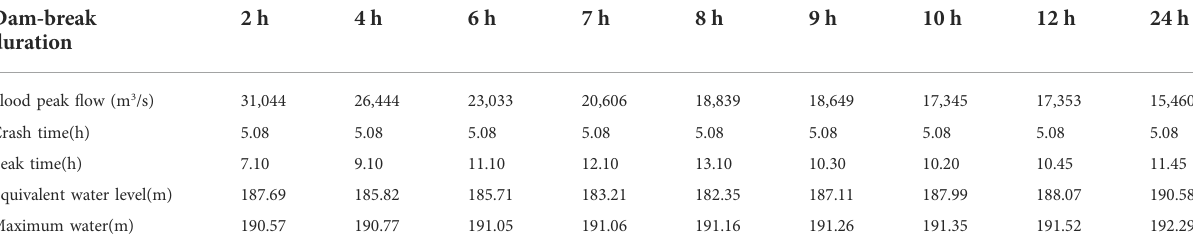
TABLE 3 Information on the peak discharge of the dam-break.